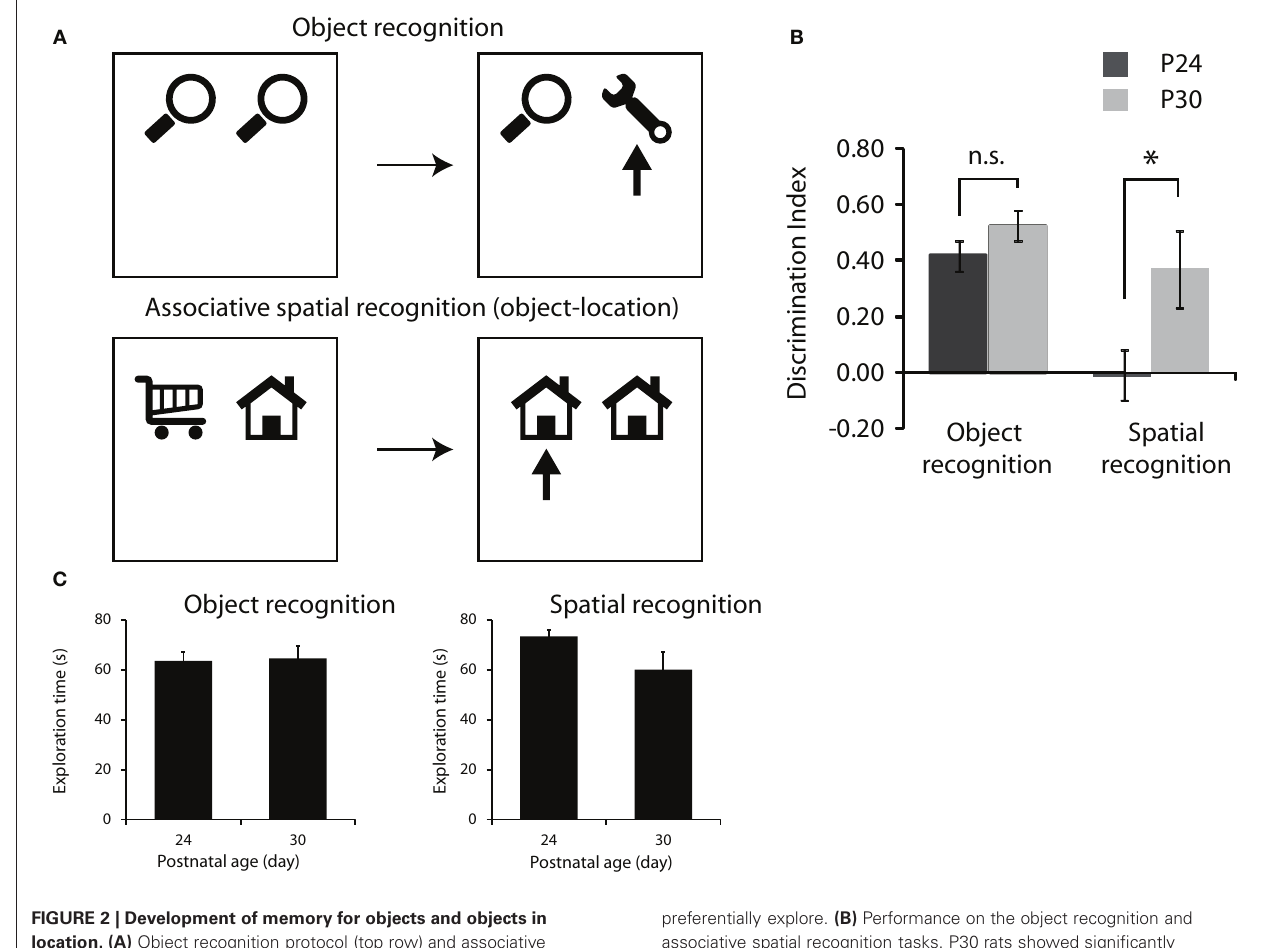
FIGURE 2 | Development of memory for objects and objects in location. (A) Object recognition protocol (top row) and associative spatial recognition protocol (bottom row). Both tasks consist of a sample phase where rats are presented with two objects to explore (left schematics) followed by a 2min delay and a test phase (right schematics) where rats are given different combinations of objects to test memory for object or object in location. Arrows in test phase schematics represent the novel object or combination of object and location that we would expect the rats to